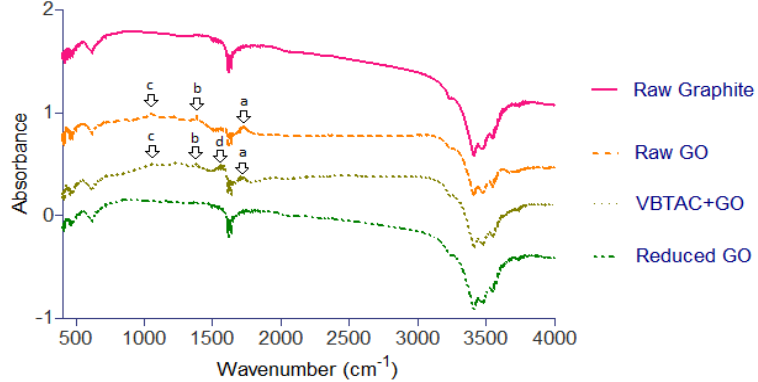
Figure 4. FTIR spectra of raw graphite, GO, reduced GO, and VBTAC-modified GO.